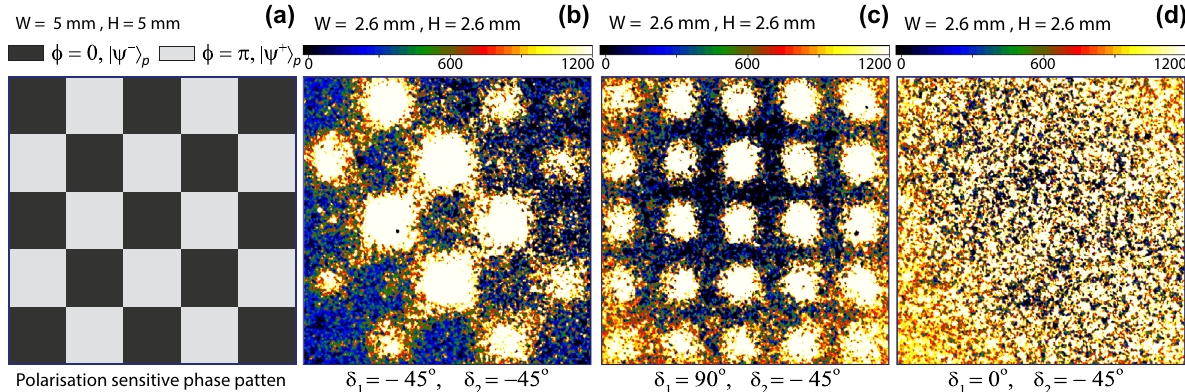
1 mm size of each square, a darker × d − d − 1 and 2 . | � | � d − 2 . In this case, only the edges of | �